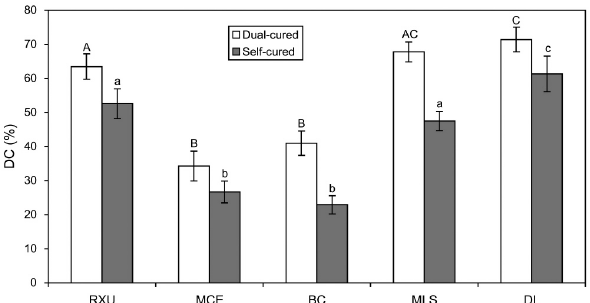
Figure 1. Degree of conversion (DC) of the resin cements polymerized in either dual- or self-cure mode ( n = 5). The vertical bars indicate standard deviations. Upper- and lower-case letters indicate statistically similar means within the dual-cured and self-cured specimens, respectively ( p > 0.05). For all materials, there were significant differences in the value between the two curing modes ( p < 0.05). Table 2. Mean values (standard deviations) of surface energy parameters (mJ/m 2 ) of the resin cements tested ( n = 5).